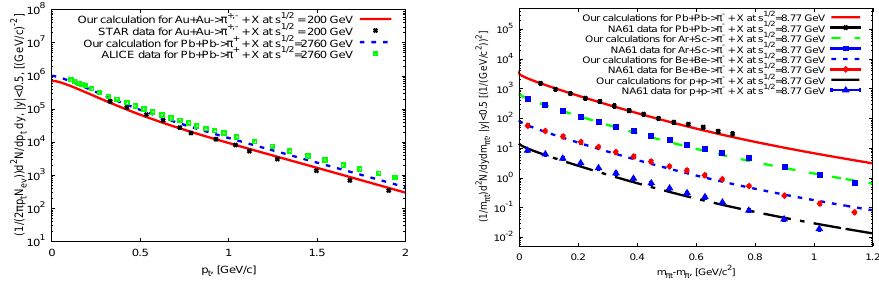
Figure 3. Left: results of our calculations of pion p T -spectra in AuAu and PbPb collisions in the mid- rapidity region ( | y | < 0.5) compared to the STAR [22, 23] and ALICE [24–27] data. Right: Results of our calculations of pion m π t -spectra in PbPb , ArSc , BeBe and pp collisions at the initial momentum per nucleon P in = 40 GeV / c and the mid-rapidity region compared to the NA61 [28, 29] data